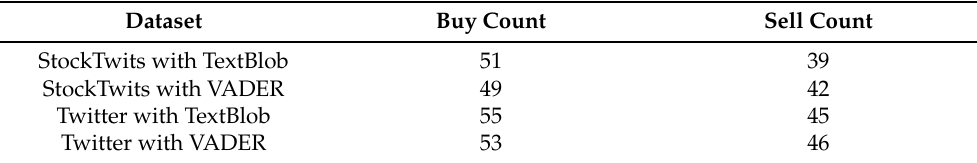
Table 5. Stock movement distribution per data